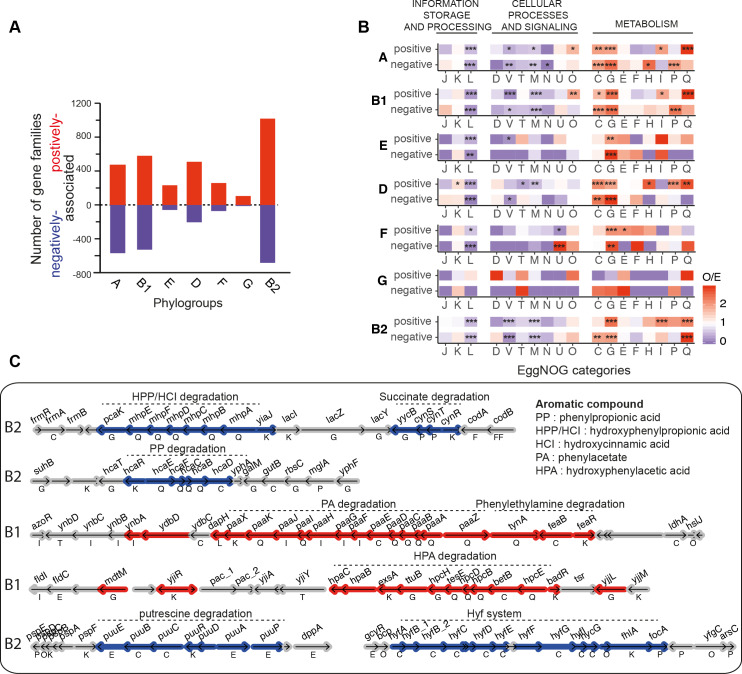
Genetic determinants of each phylogroup.A. Number of gene families positively (in red) and negatively (in blue) associated with each phylogroup. Altogether, they represent 7% of the accessory gene families of the dataset (note that some gene families are associated with several phylogroups). B. Observed/expected (O/E) ratios of non-supervised orthologous groups (NOGs, shown as capitalized letters, same code as shown in Fig 1C) in the positively or negatively associated gene families. For example, in phylogroup A there is an over-represents of positive associations in class Q, whereas in class L for the same phylogroup A there is under-represention for both positive and negative associations. The ratio (O/E) was reported for all comparisons with a color code ranging from blue (under-representation) to red (over-representation). The level of significance of each Fisher’s exact test was indicated (P> = 0.05 : ns; P<0.05 : *; P<0.01 : **; P<0.001 :***). It was performed on each 2*2 contingency table. Gene families lacking matches to the EggNOG functional categories (57%) were discarded. C. Genomic organization of some regions enriched in genes positively (in red) or negatively (in blue) associated with a phylogroup (indicated on the left). Genes shown in grey are not significantly associated. The name of the gene (when available) is shown above it, its EggNOG functional category (when known) below it.